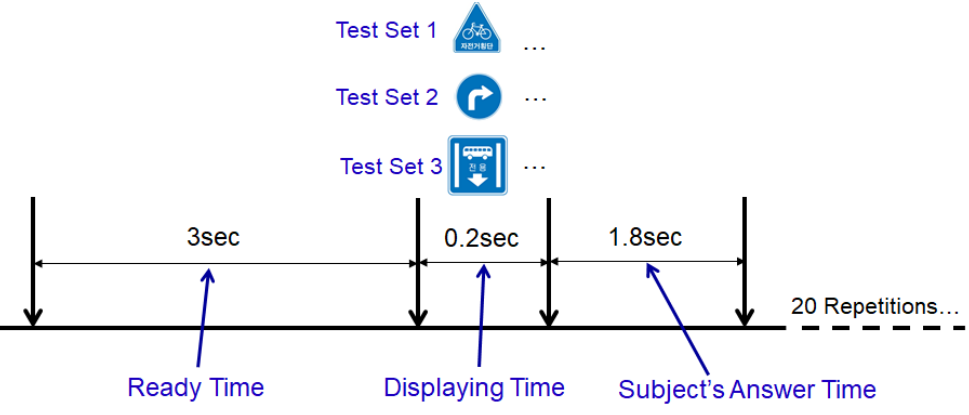
Figure 3. Subject traffic sign recognition sequence for each test item: Assuming a driving state, it was displayed on the screen for a short time of 0.2 s, and sufficient time was given to the next sign.